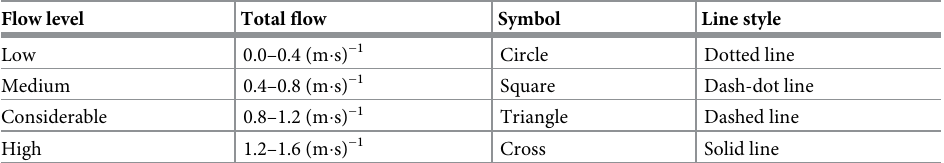
Table 4. Legend for symbol and line styles used in presenting the results in relation to flow